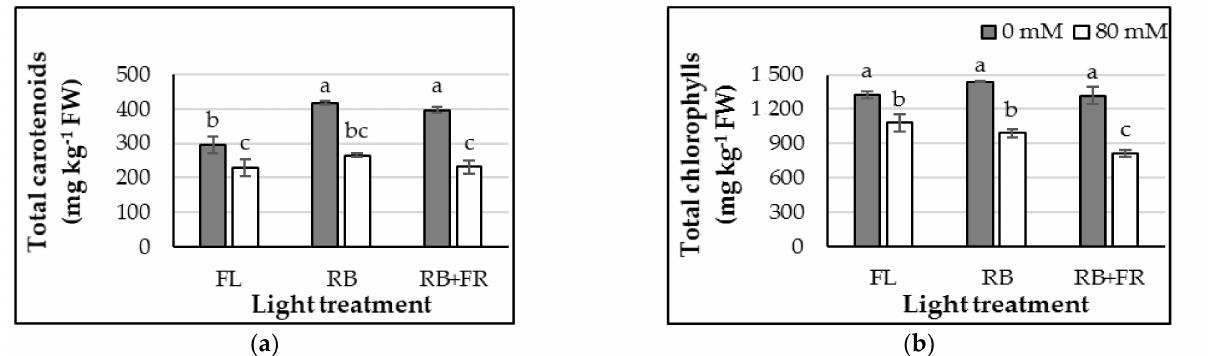
Figure 4. Effect of the different light (FL, RB and RB+FR) and salinity (0 and 80 mM NaCl) combinations on total carotenoids ( a ) and total chlorophylls ( b ) of purslane microgreens. Values are mean ± SE (n = 3). Different letters indicate significant differences ( p ≤